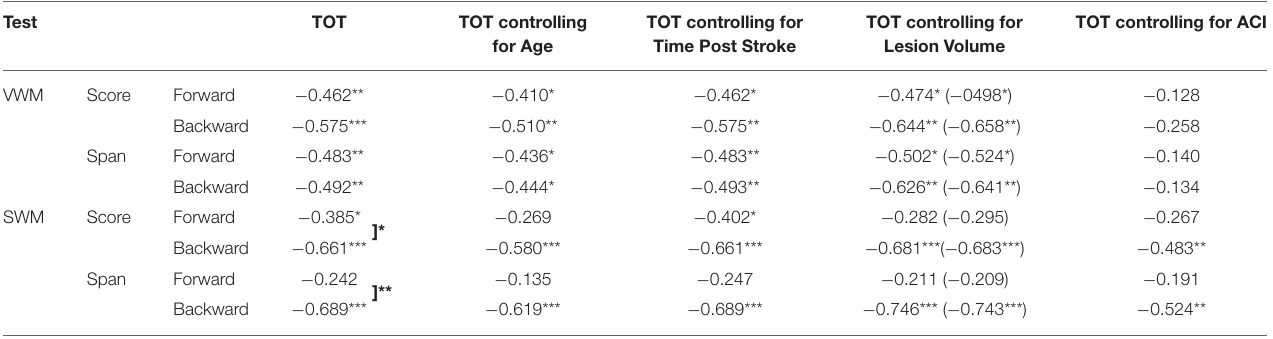
TABLE 6 | Spearman’s rho correlation coefficients (and significance levels) between particular outcome measures of VWM and SWM on the forward and backward tasks (scores and spans) and temporal order threshold (TOT) values. Test TOT TOT controlling